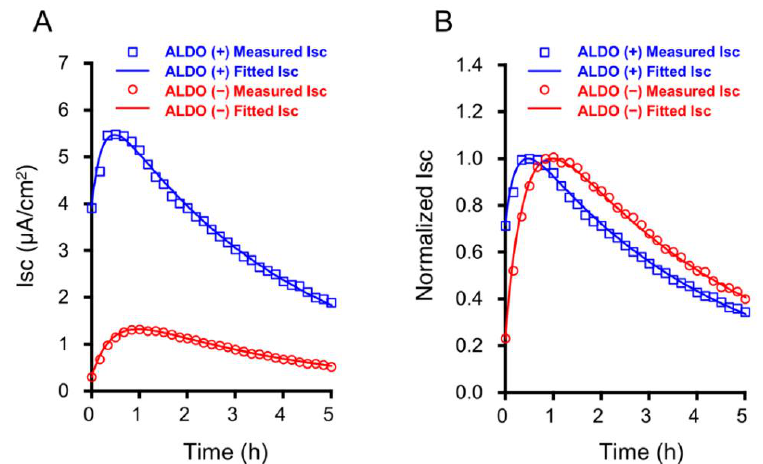
Figure 2. Representative observations of experimentally measured insulin (100 nM)-stimulated short-circuit currents (I SC ) and simulated I SC using a four-state mathematical model with and without treatment of aldosterone (ALDO, 1 µ M for 20 h). ( A ) Blue squares and line respectively indicate a typical time course of experimentally measured insulin-stimulated I SC (blue squares) and a simulated time course of I SC (blue line) in cells with 1 µ M aldosterone-treatment for 20 h. Red circles and line respectively indicate a typical time course of experimentally measured insulin-stimulated I SC (red circles) and a simulated time course of I SC (red line) in cells without aldosterone-treatment. ( B ) Normalized I SC to each peak value of I SC = 1. Blue squares and line respectively show the normalized measured I SC and simulated I SC in cells with 1 µ M aldosterone-treatment for 20 h. Red circles and line respectively show the normalized measured I SC and simulated I SC in cells without aldosterone-treatment. Table 1. Evaluated values of ENaC’s tra ffi cking rates in the presence and absence of 100 nM insulin with and without 1 µ M aldosterone treatment for 20